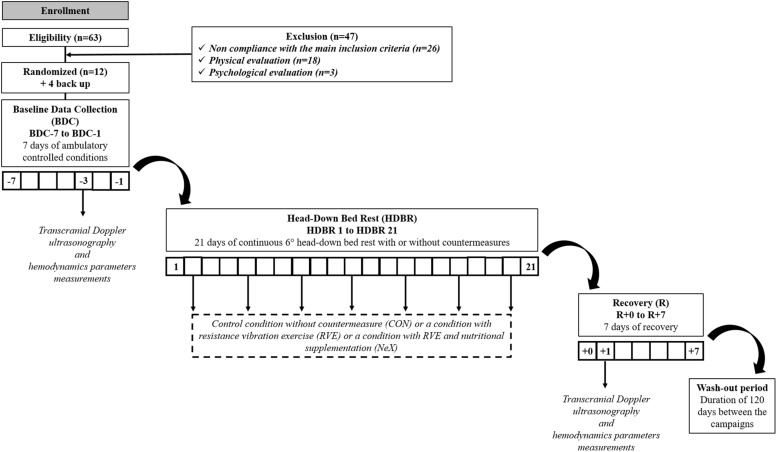
Flow chart of the study and timeline of data collection.